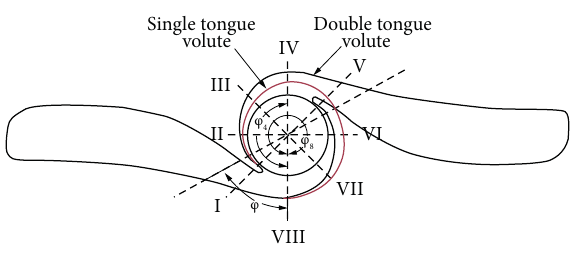
Figure 2: Plane design of double tongue volute